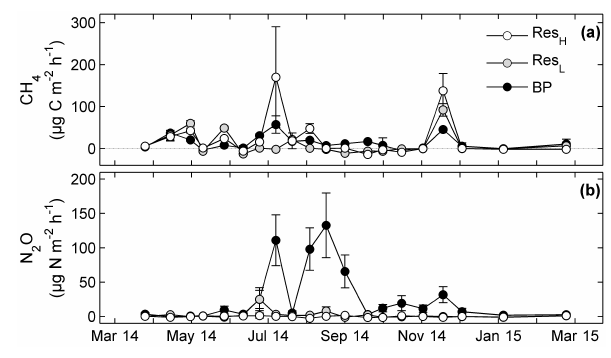
Figure 3. Measured fluxes of (a) methane (CH 4 ; µgCm − 2 h − 1 ) and (b) nitrous oxide (N 2 O; µgNm − 2 h − 1 ) in restoration treat- ments with high (Res H ) and low (Res L ) water table level and bare peat (BP); error bars indicate standard error; the horizontal dotted line in (a) visualizes the zero line above and below which CH 4 emis- sion and uptake occur,